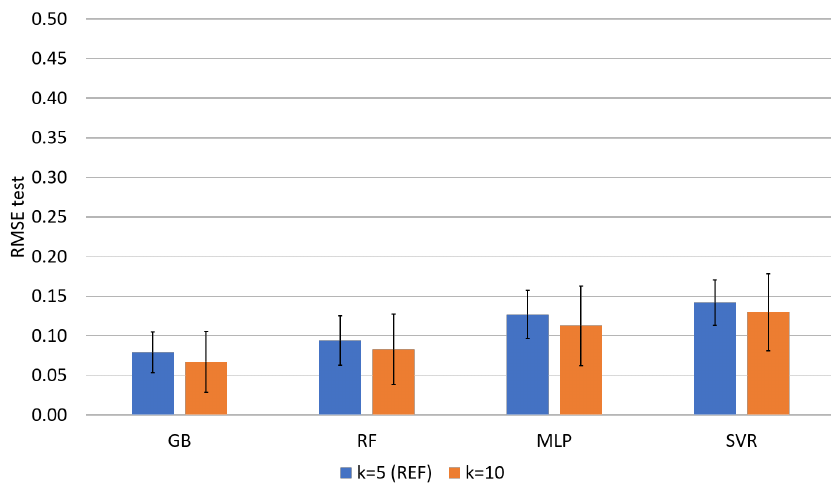
Figure E3. Partitioning train/test impact on test RMSE, without HP optimization.